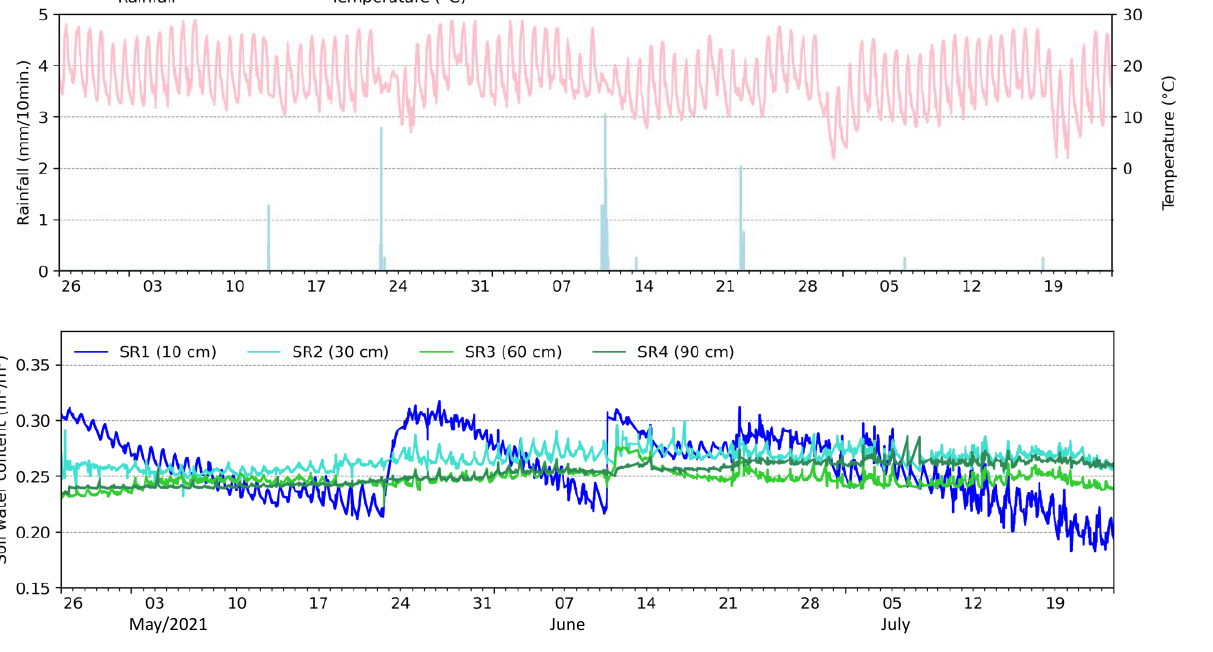
Figure 12. Observed soil moisture oscillations under field conditions.